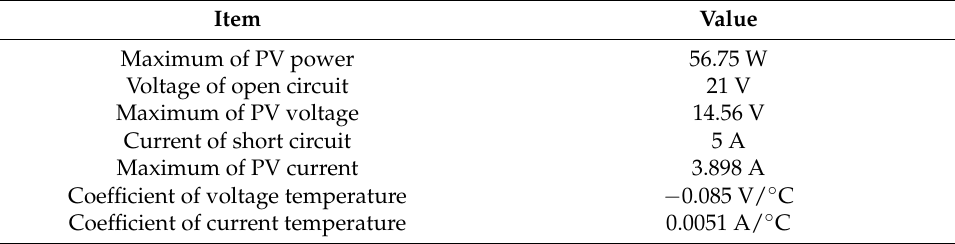
Table 3. DC/DC boost converter parameters [9,10].